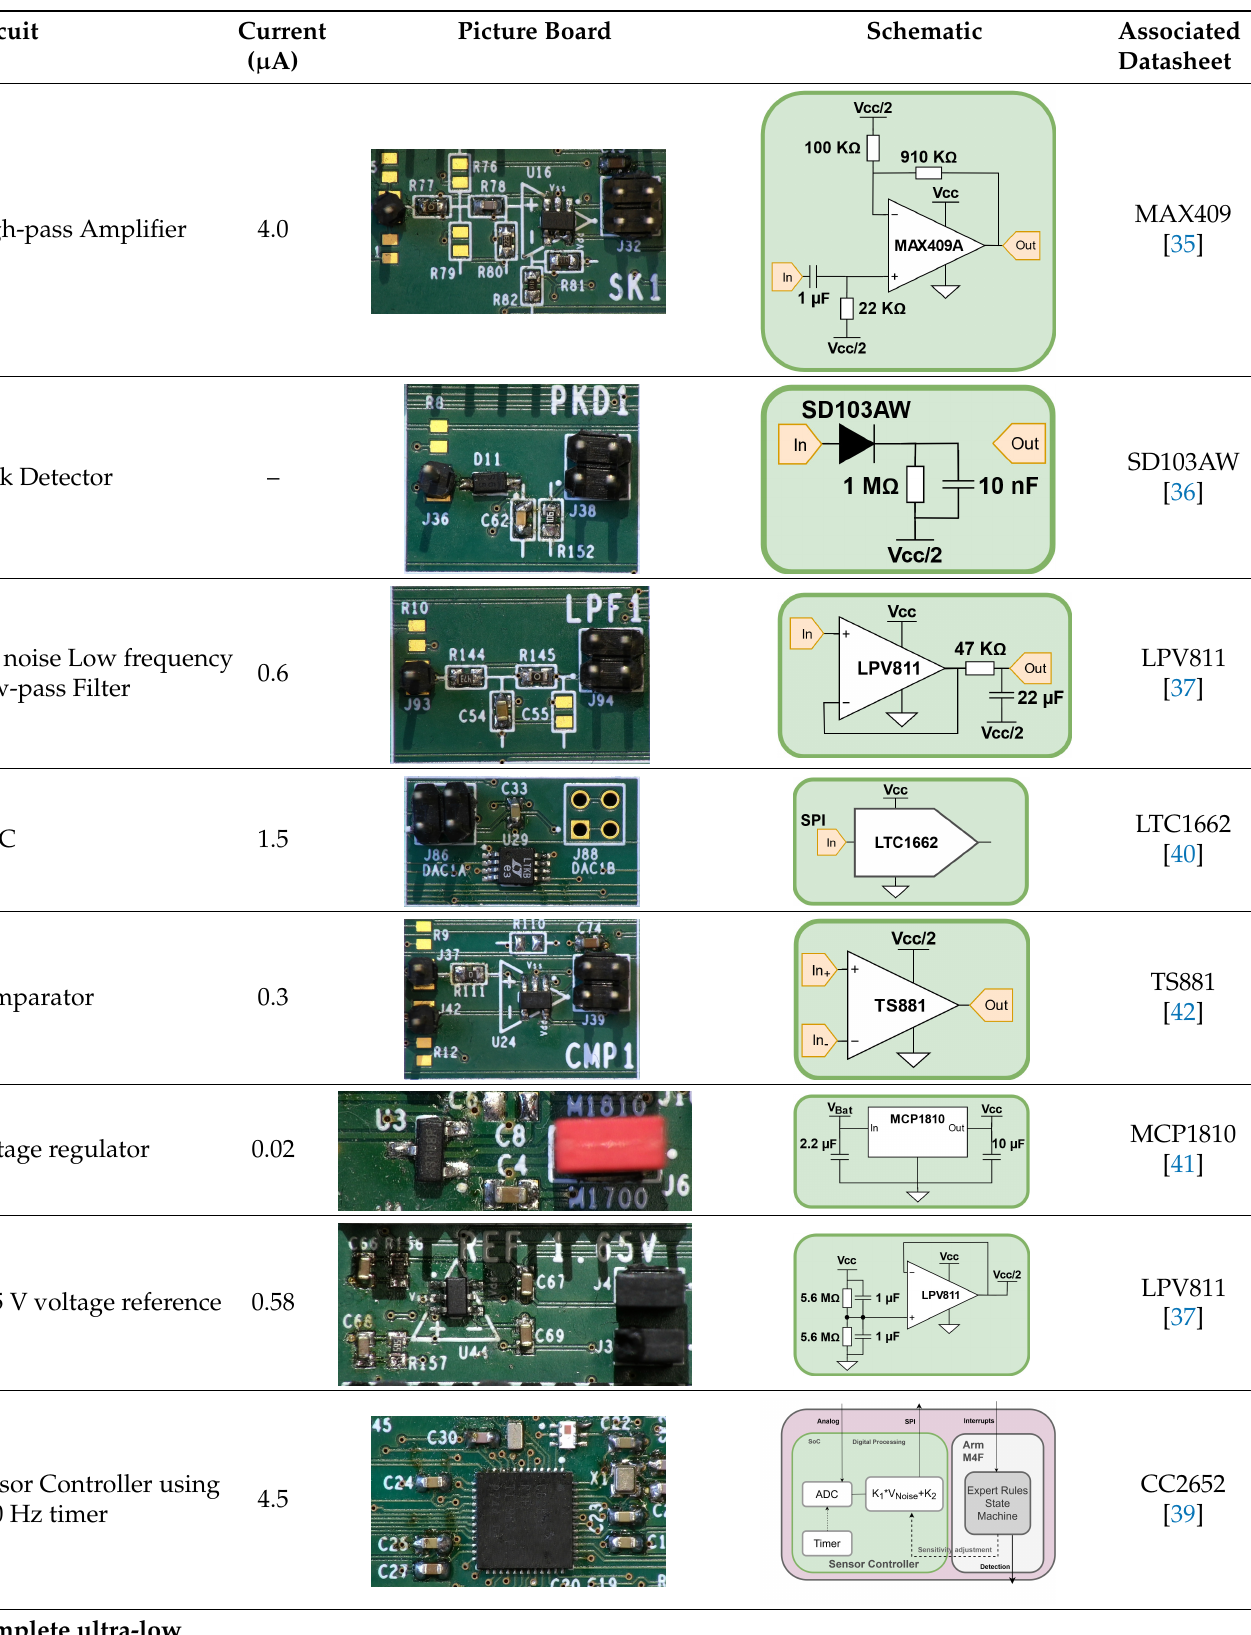
Table 2. Always-on ultra-low power analog circuits implementation and supply current ( µ